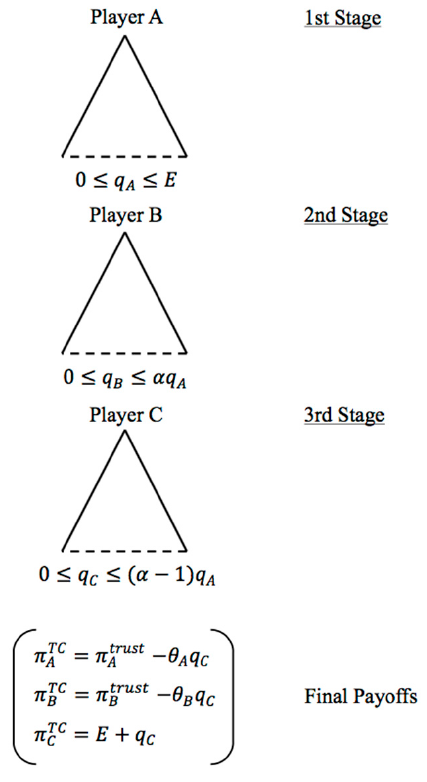
Figure 1. The trust game with corruption.